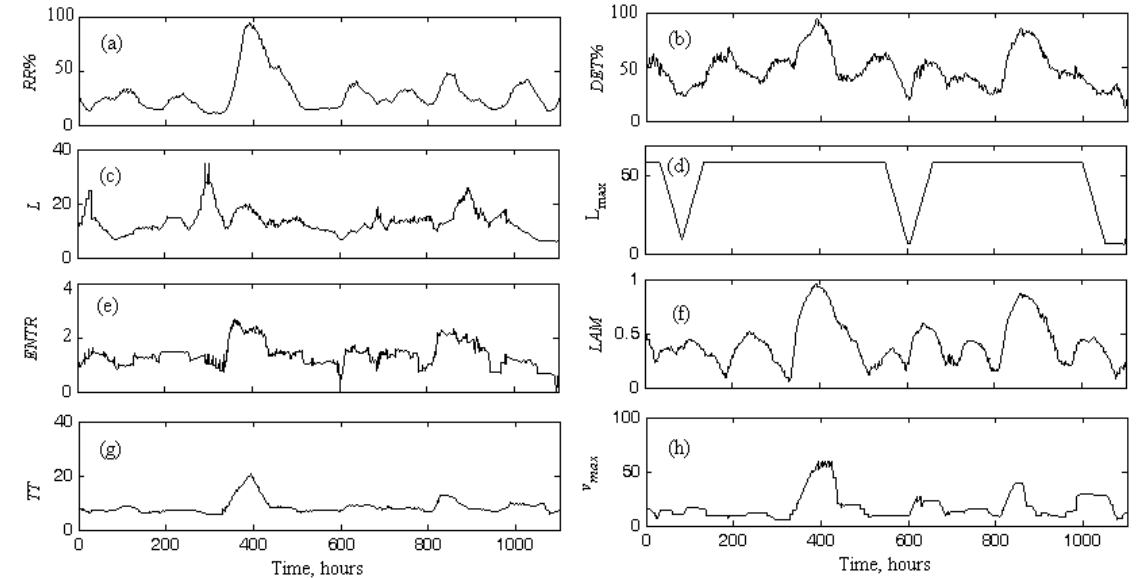
Figure 12. RQA measures for wind speed (a) RR %, (b ) DET %, (c) L , (d) Lmax , (e) ENTR , (f) LAM %, (g) TT, and (h) Vmax